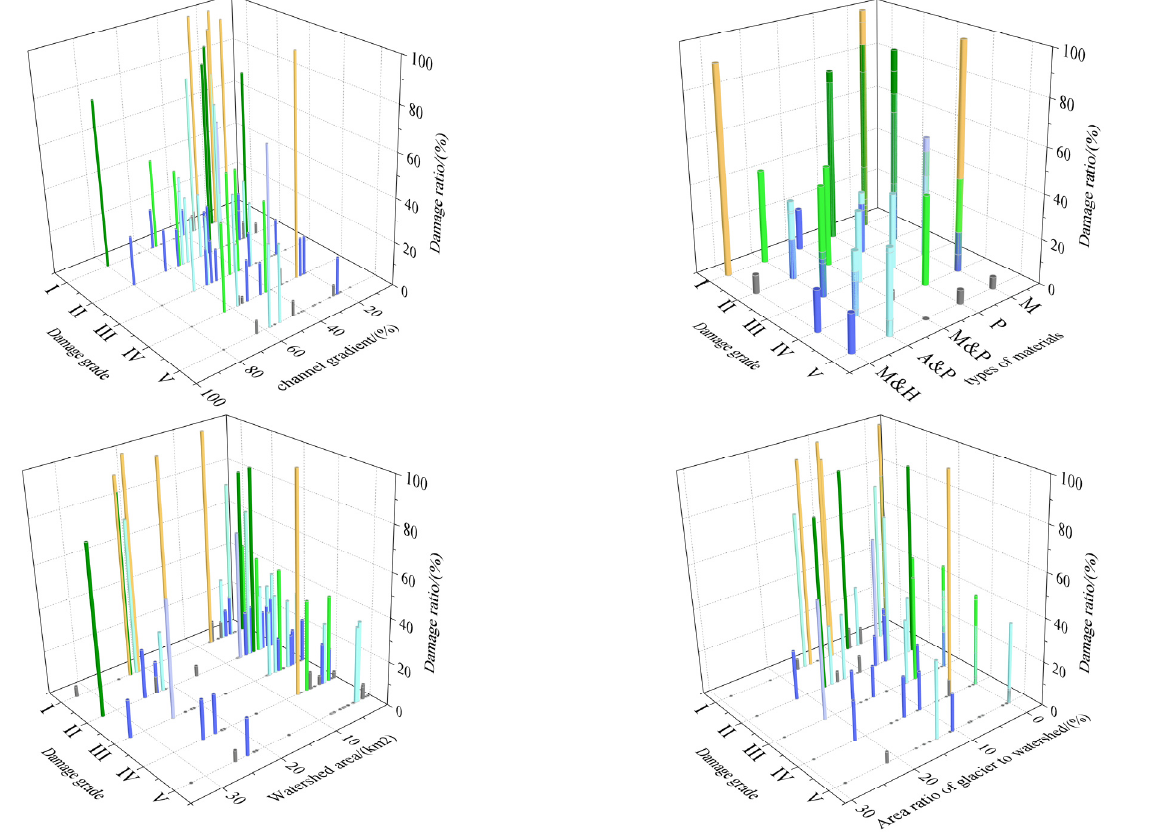
Figure 6. The relationship between debris flow formation conditions and damage grade.